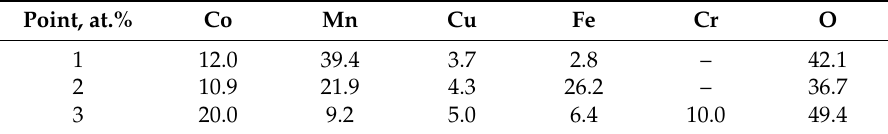
Table 4. Composition analysis by EDS of the local region in Figure 6.